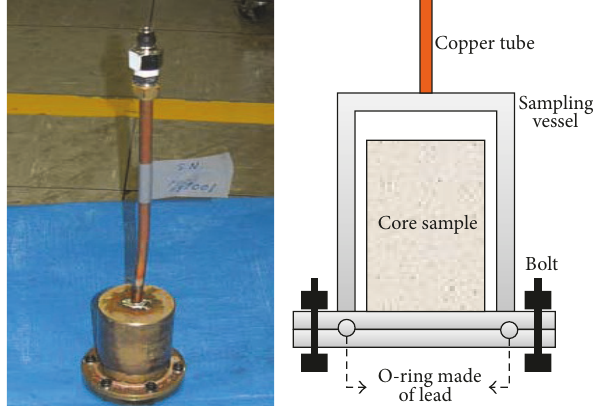
Figure 3: Appearance and schematics diagram of core sampling vessel used for dissolved gases